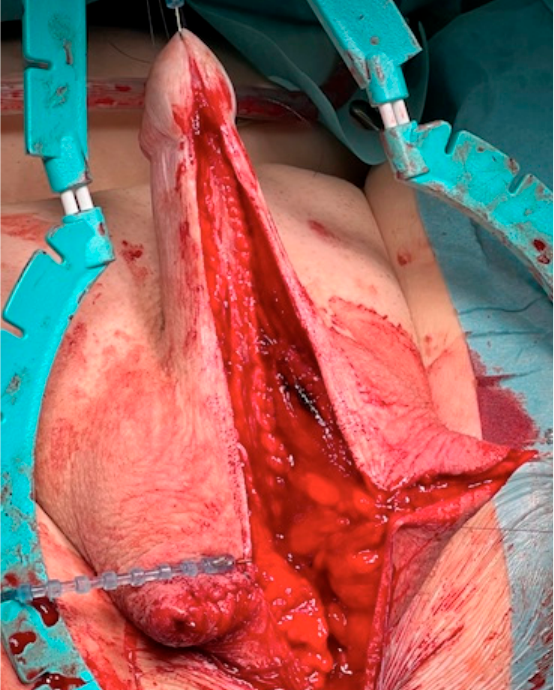
Figure 2. Closure of the divided raphe over the testis.